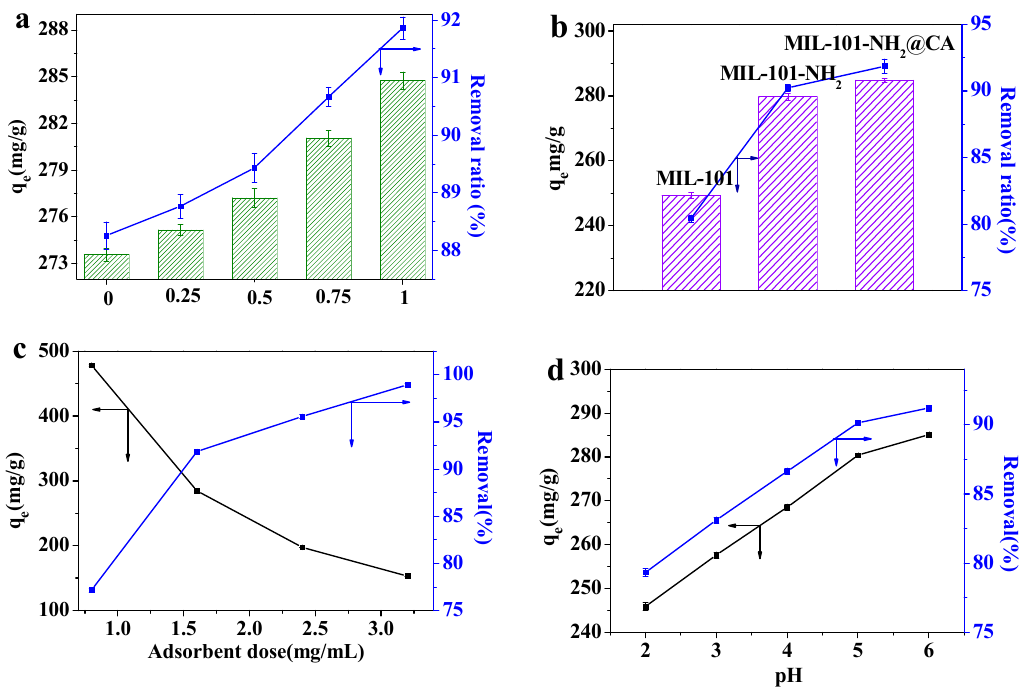
Figure 4. ( a ) The effect of mass ratio for MIL-101-TEPA and CA on the q e ; ( b ) comparison of adsorption capacities of different materials; ( c ) effect of the adsorbent dose on q e ; ( d ) effect of pH on q e .